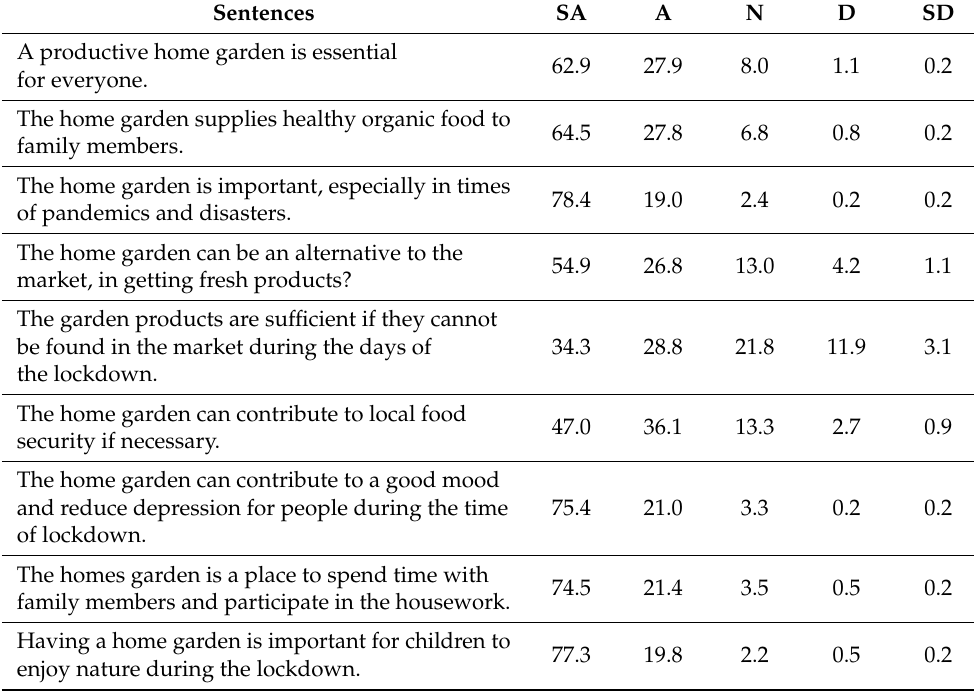
Table 3. The Respondent’s Opinion regarding the Importance of a Home Garden During